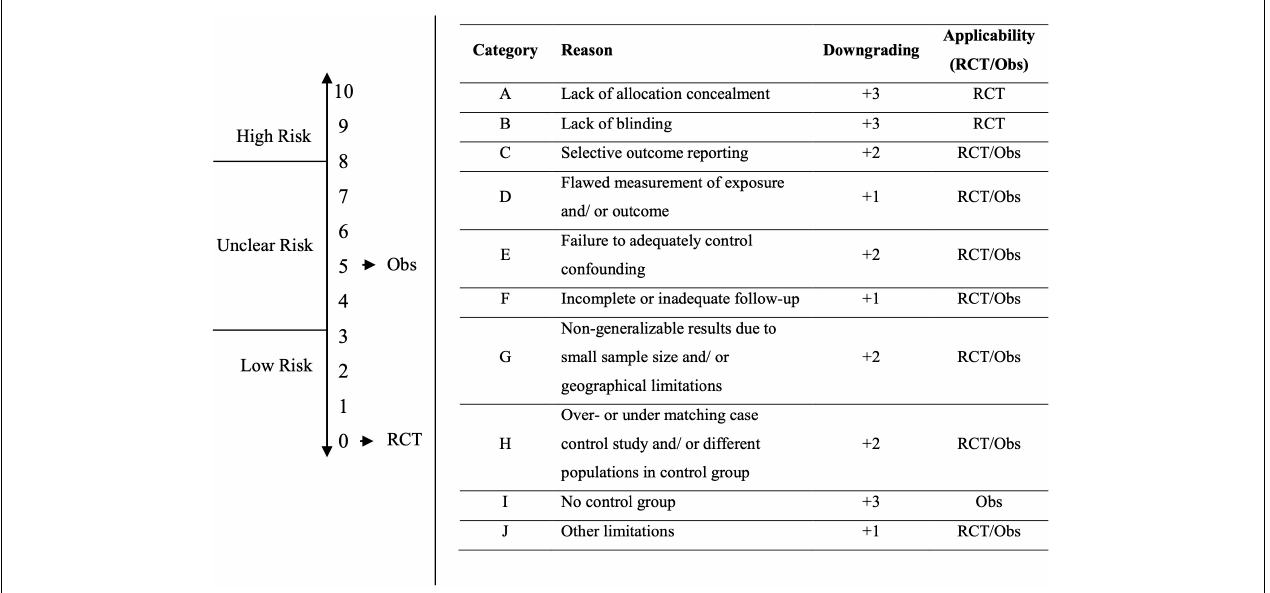
FIGURE 1 | Risk of Bias assessment based on GRADE assessment. Starting point for RCTs is “Low Risk” with 0 points. Starting point for Obs is at “Unclear Risk” with 5 points. For each limitation, the corresponding downgrade (+1, +2, +3) is made on the scale (0 to 10), which results in the categorization of the risk of bias (Low, Unclear, High). Downgrading scores and categorization to low, unclear, and high risk were defined by the